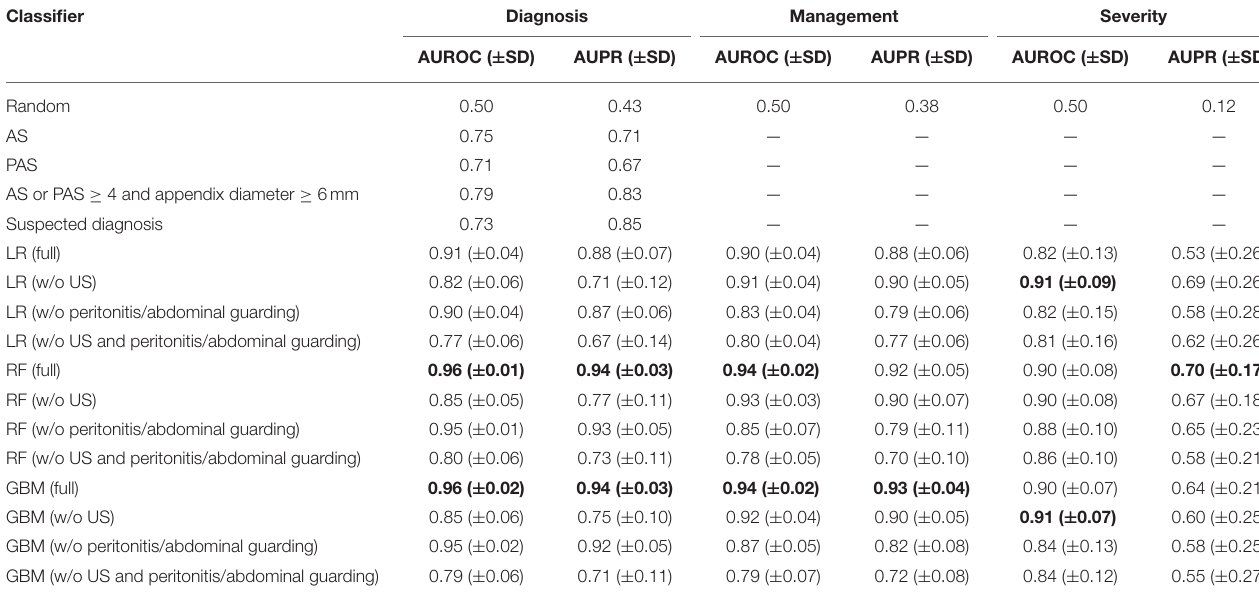
TABLE 3 | Ten-fold cross-validation results for logistic regression (LR), random forest (RF), and generalized boosted regression (GBM) models for predicting diagnosis, management, and severity.